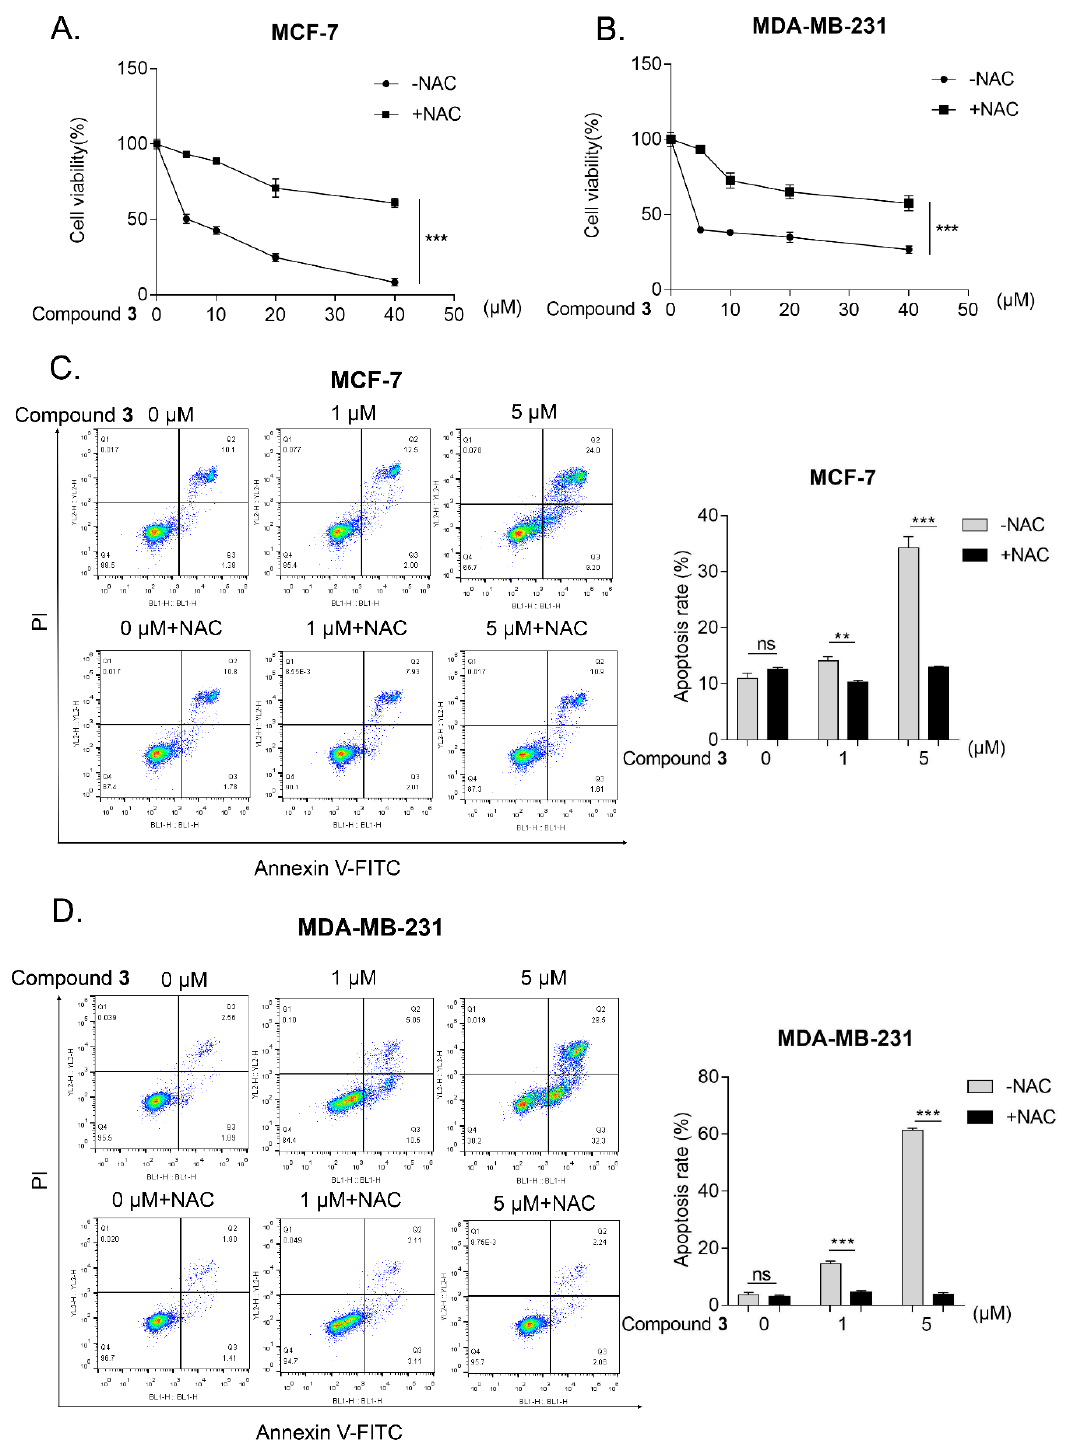
Figure 6. ROS are involved in compound 3-induced cancer cells apoptosis. ( A , B ), MCF-7 ( A ) and MDA-MB-231 cells ( B ) were pre-treated with NAC (1 mM) for 1 h and then treated with different concentration of compound 3 for 24 h, MTT assay was used to examine the cell viability; ( C , D ), MCF-7 ( C ) and MDA-MB-231 cells ( D ) were exposed to the indicated concentration of compound 3 or co-treated with 1 mM NAC for 24 h and the cell apoptosis was detected by flow cytometry and bar chart indicated that the apoptosis rate via FlowJo software. ** p < 0.01, *** p < 0.001; ns represents nonsignificant